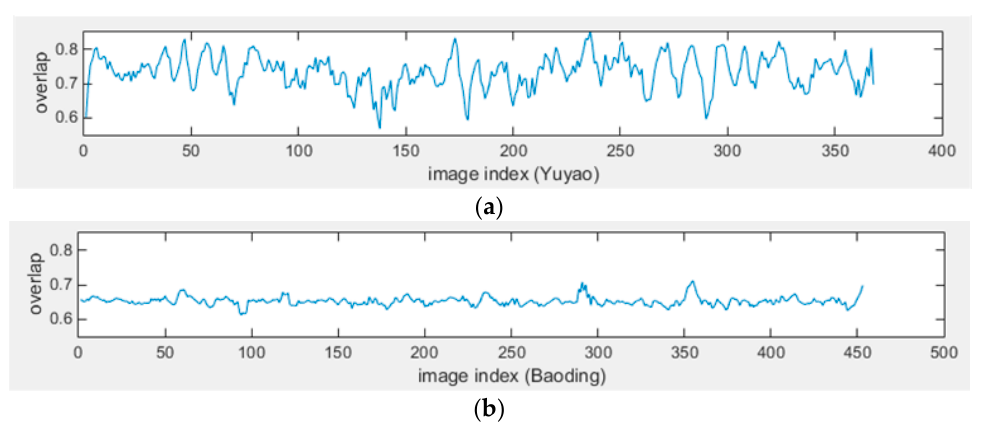
Figure 12. Comparison of overlaps in forward direction of experimental datasets. ( a ) Yuyao; ( b ) Baoding.